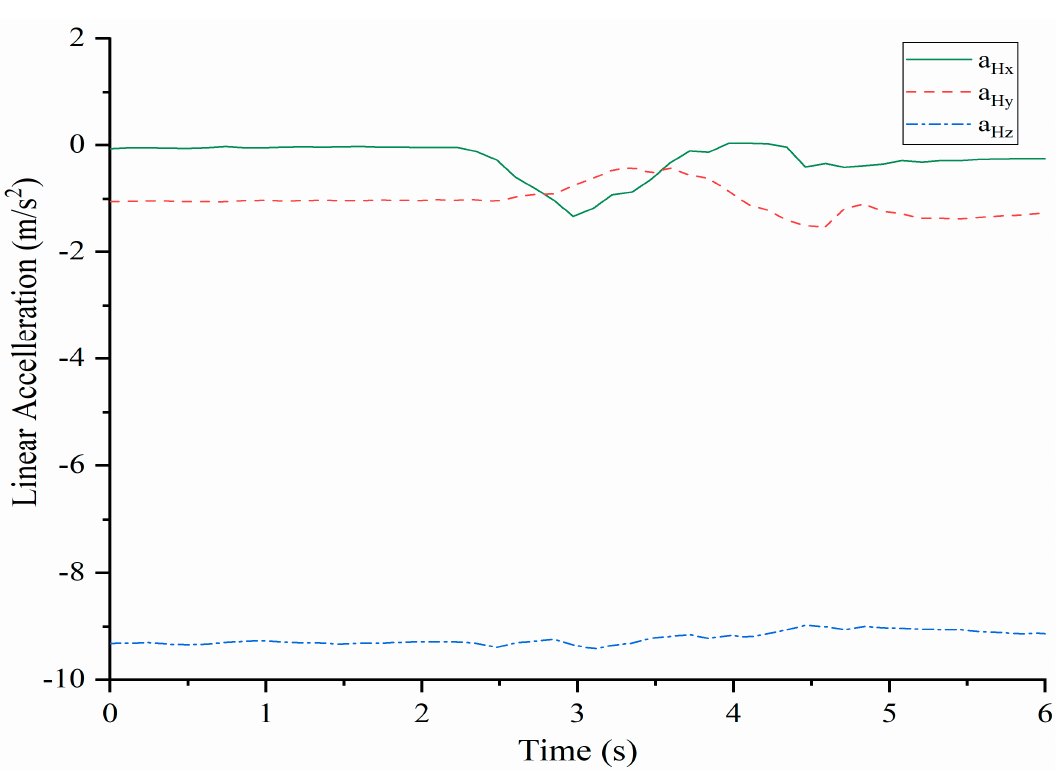
Figure 8. Acquired angular velocity of the shoulder during a full rotation testing, Table 2.